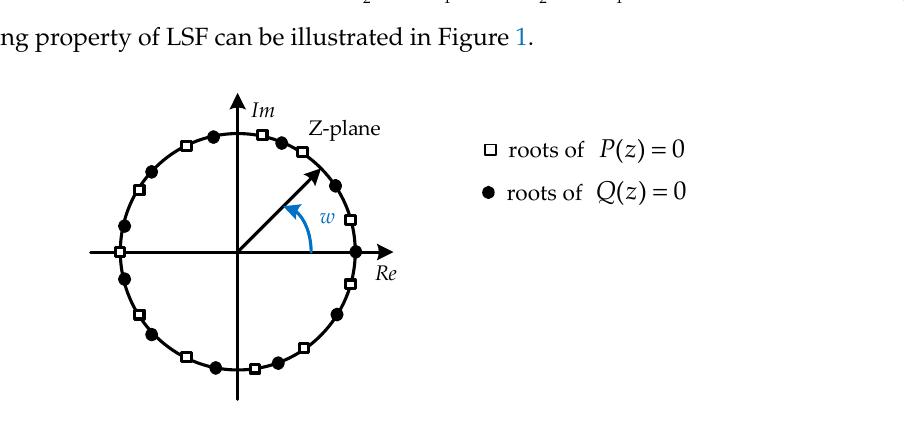
Figure 1. Illustration of the root location P = 10 (even).